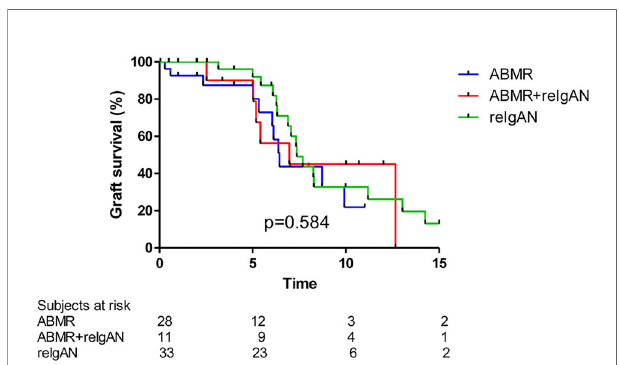
FIGURE 5 | Death-censored graft survival in patients with ABMR, reIgAN + ABMR, and reIgAN is similar (log rank p value p = 0.584). ABMR, antibody